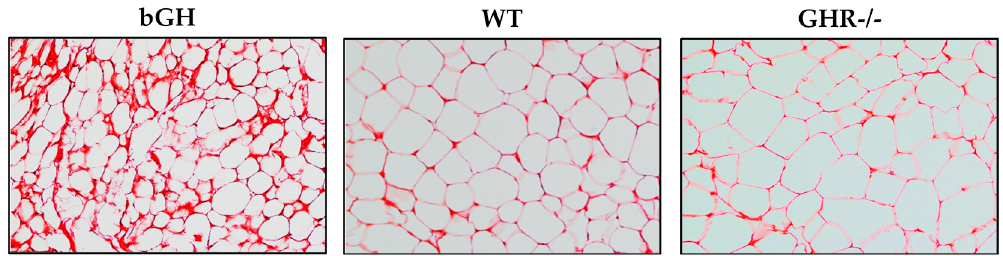
Figure 5. Comparison collagen staining in AT. SubQ AT from five-month-old bGH, wild-type (WT) controls and GHR-/- mice stained with Picrosirius red, a commonly-used histological technique to visualize collagen in paraffin-embedded tissue sections. Adapted with permission from [38].